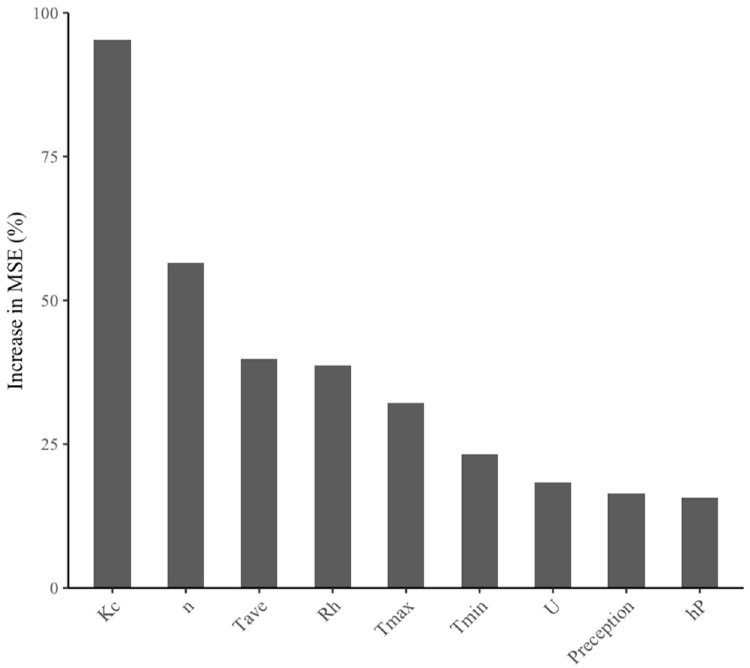
Figure 2. Plot of variable importance ranking, where variable importance is expressed as the per- centage increase in mean squared error (%IncMSE). Each value represents the increase in prediction error of the same model after a variable is